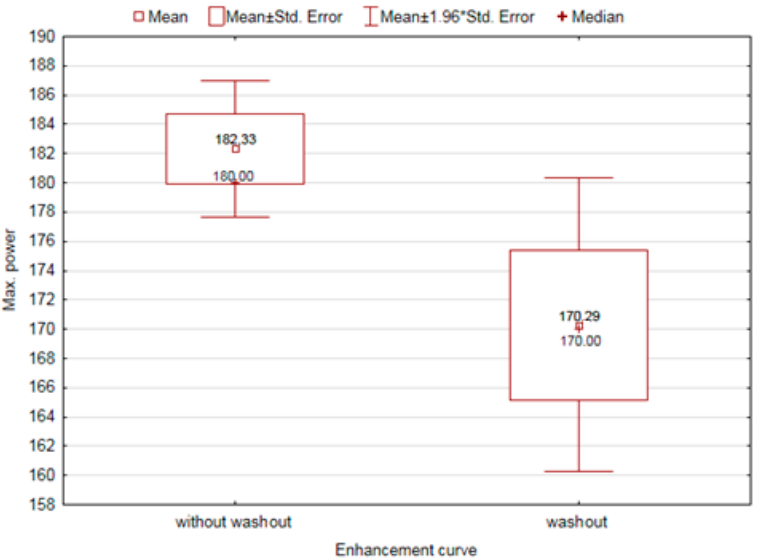
Figure 5. The effect of the distribution of the enhancement curve on the changes in the maximum applied power.